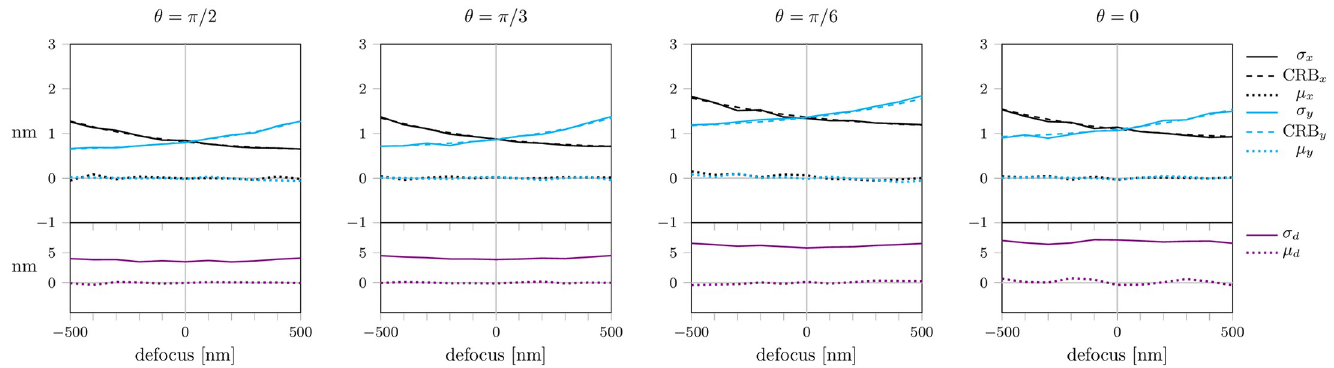
Fig 5. Influence of background noise. Simulations and fitting procedure were analogous to Fig 4, except for adding background noise with b = 100. A list of all simulation parameters is given in S1 Table in S1 File.